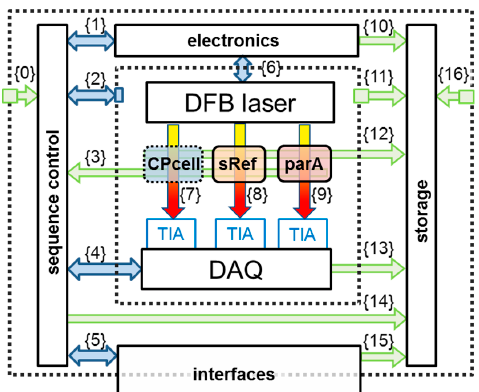
Figure 2. Graphical representation of the data flows inside the SEALDH-II instrument. The actual spectroscopic measurement path in the closed-path cell “CPcell” is embedded in a network of supplementary data flows for various instrument control purposes (marked with {numbers}). Details are described in the text.